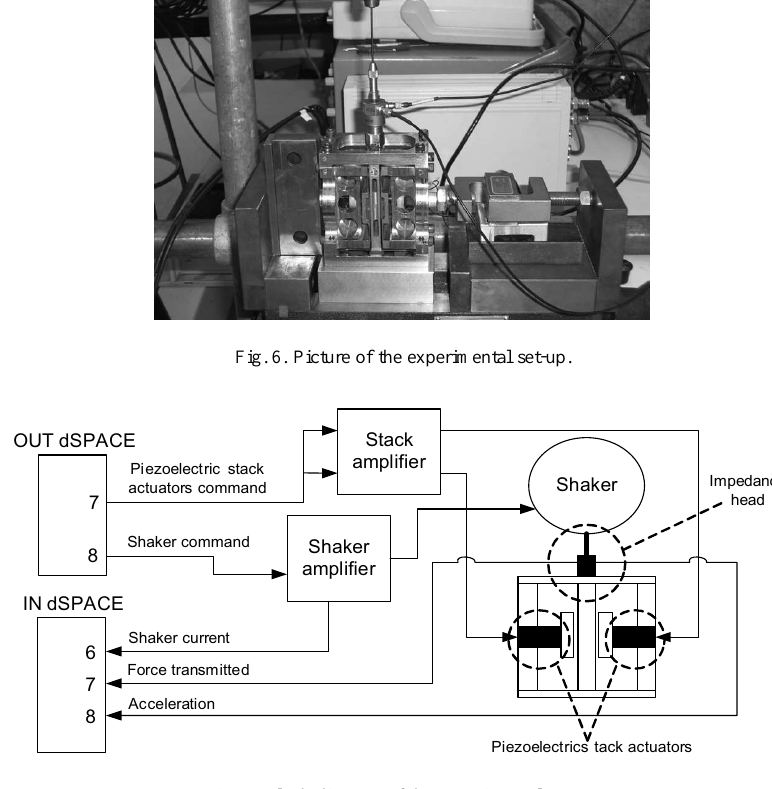
Fig. 7. Block diagram of the experimental